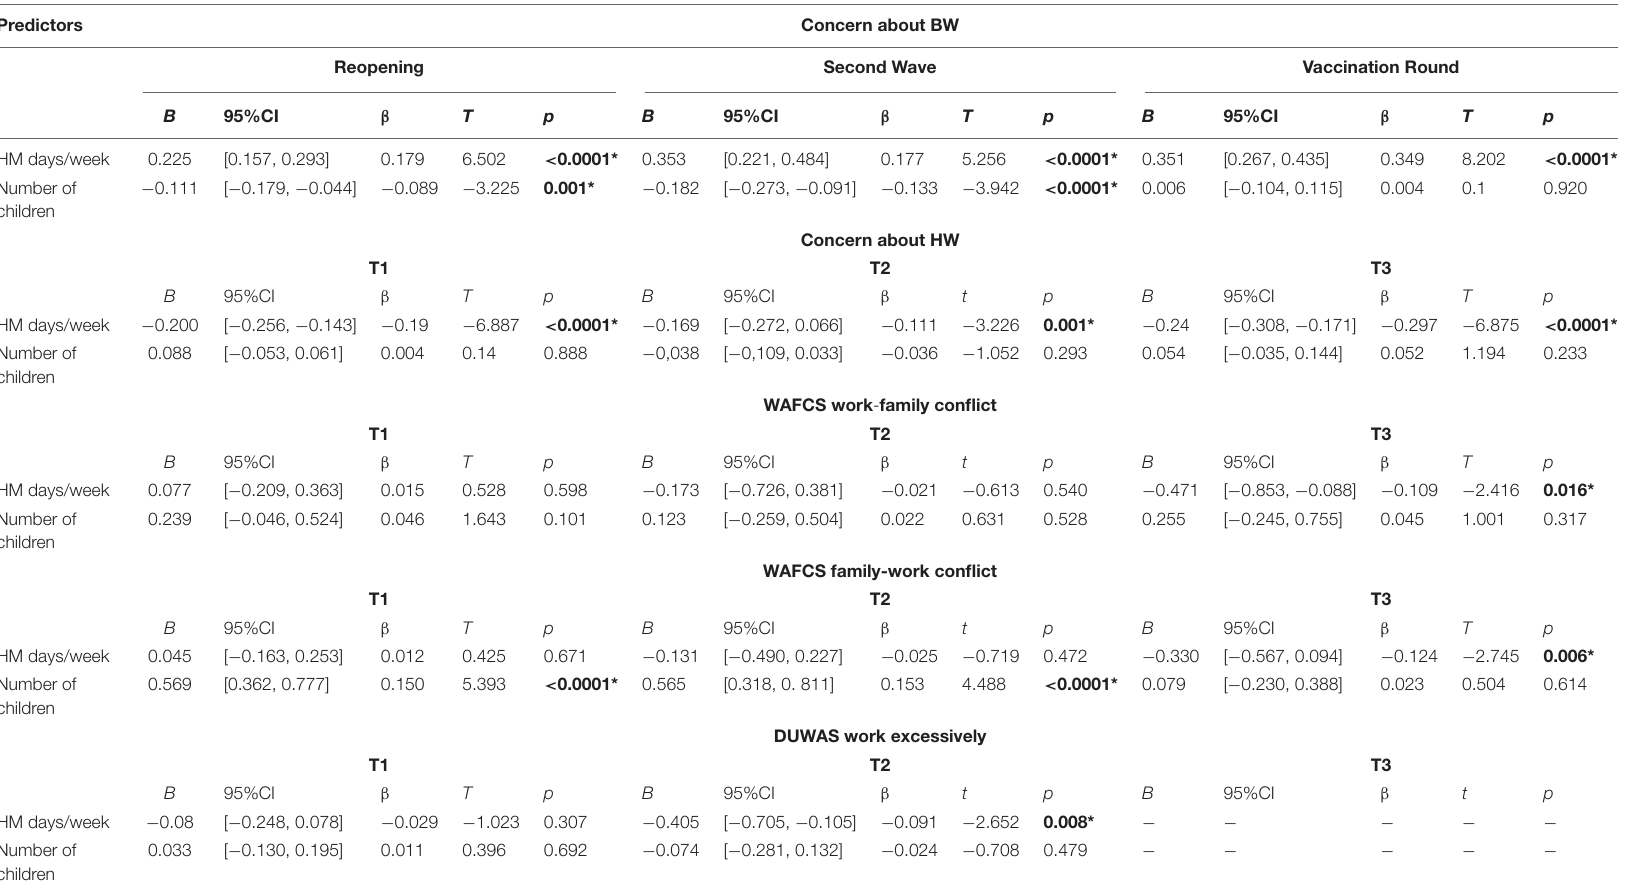
TABLE 8 | Predictors of Concern about BW and HW, WAFCS, and DUWAS variables in the three groups. Predictors Concern about